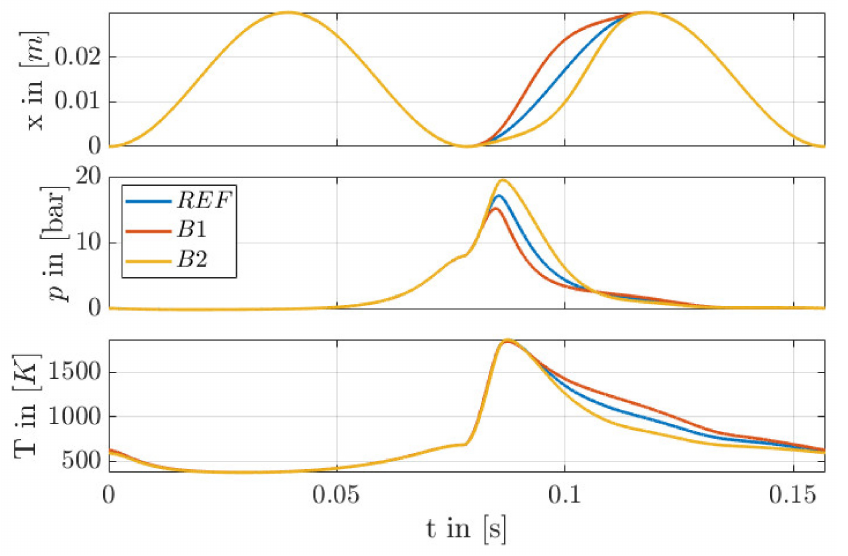
Figure 20. Comparison of trajectories REF, B1 and B2 related to the energy conversion of the internal combustion engine: illustration of the stroke, cylinder pressure and temperature depending on